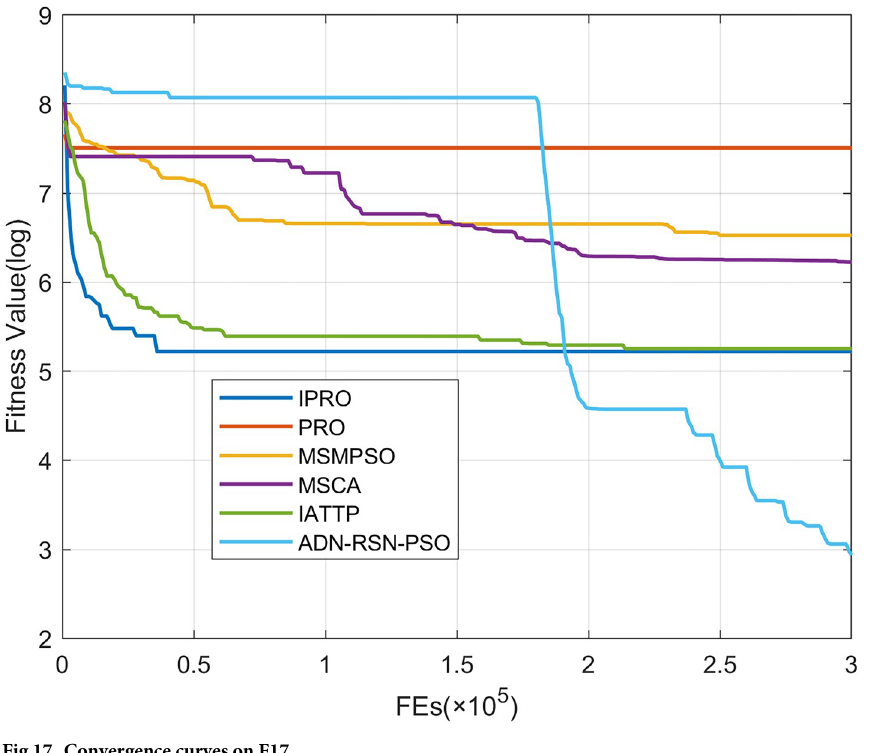
Fig 17. Convergence curves on F17.